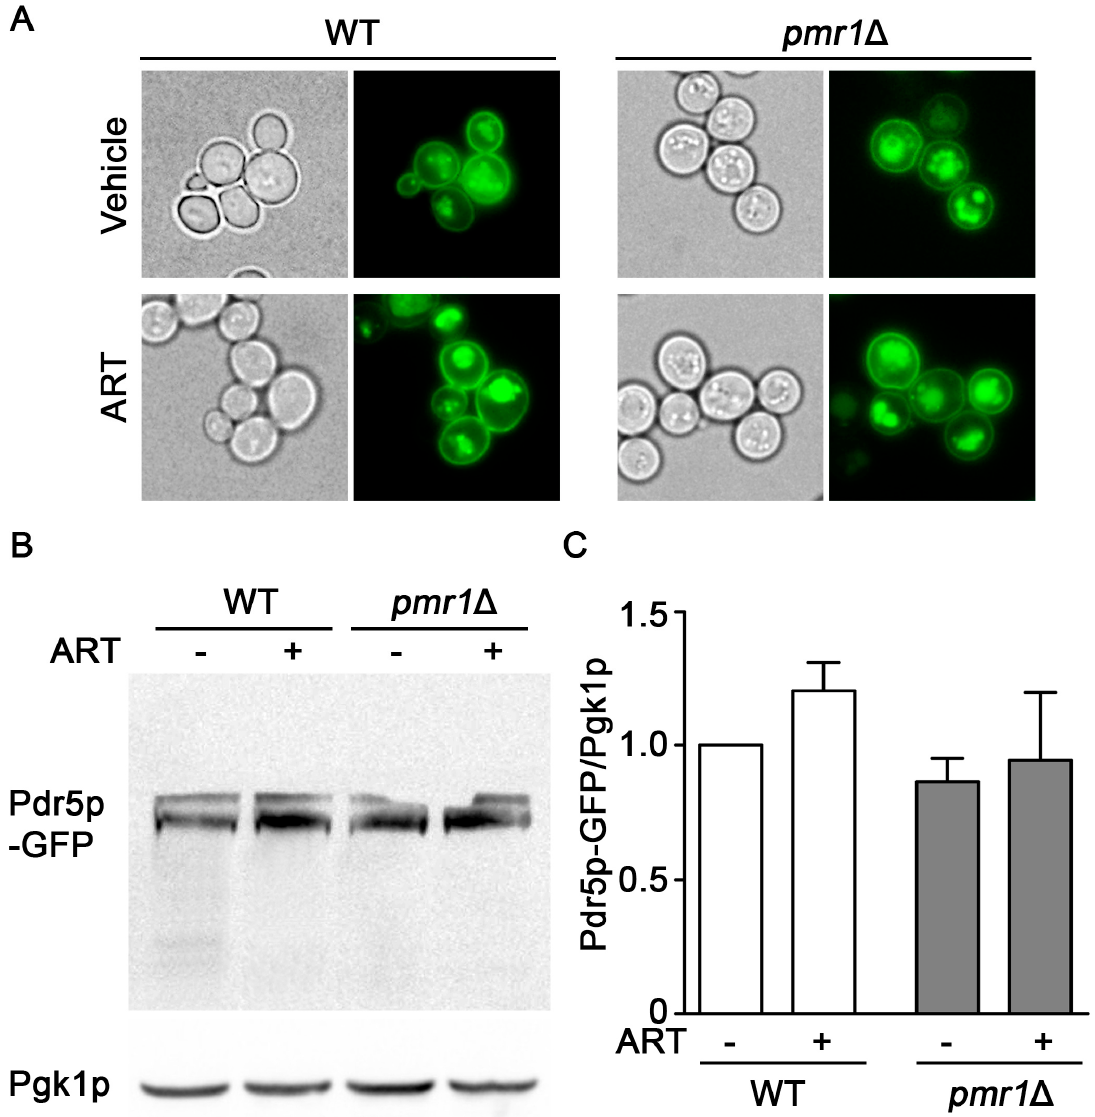
Figure 4. Localization and accumulation of the multi-drug transporter Pdr5p are similar in pmr1 ∆ and WT cells. WT and pmr1 ∆ yeast transformed with a plasmid expressing PDR5 -GFP fusion driven by the constitutive PGK1 promoter were grown overnight in SCG media with vehicle or 10 µ M artemisinin. ( A ) Cellular localization of Pdr5p-GFP was observed by fluorescence microscopy at 60x magnification. ( B ) The abundance of Pdr5p-GFP was monitored with immunoblots using Pgk1p levels as the loading control. ( C ) Quantitation of Pdr5p-GFP results are normalized to the intensity of Pgk1p with levels normalized to WT = 1. Values are mean + SD ( n = 2). No statistical difference between samples was observed using Student’s t